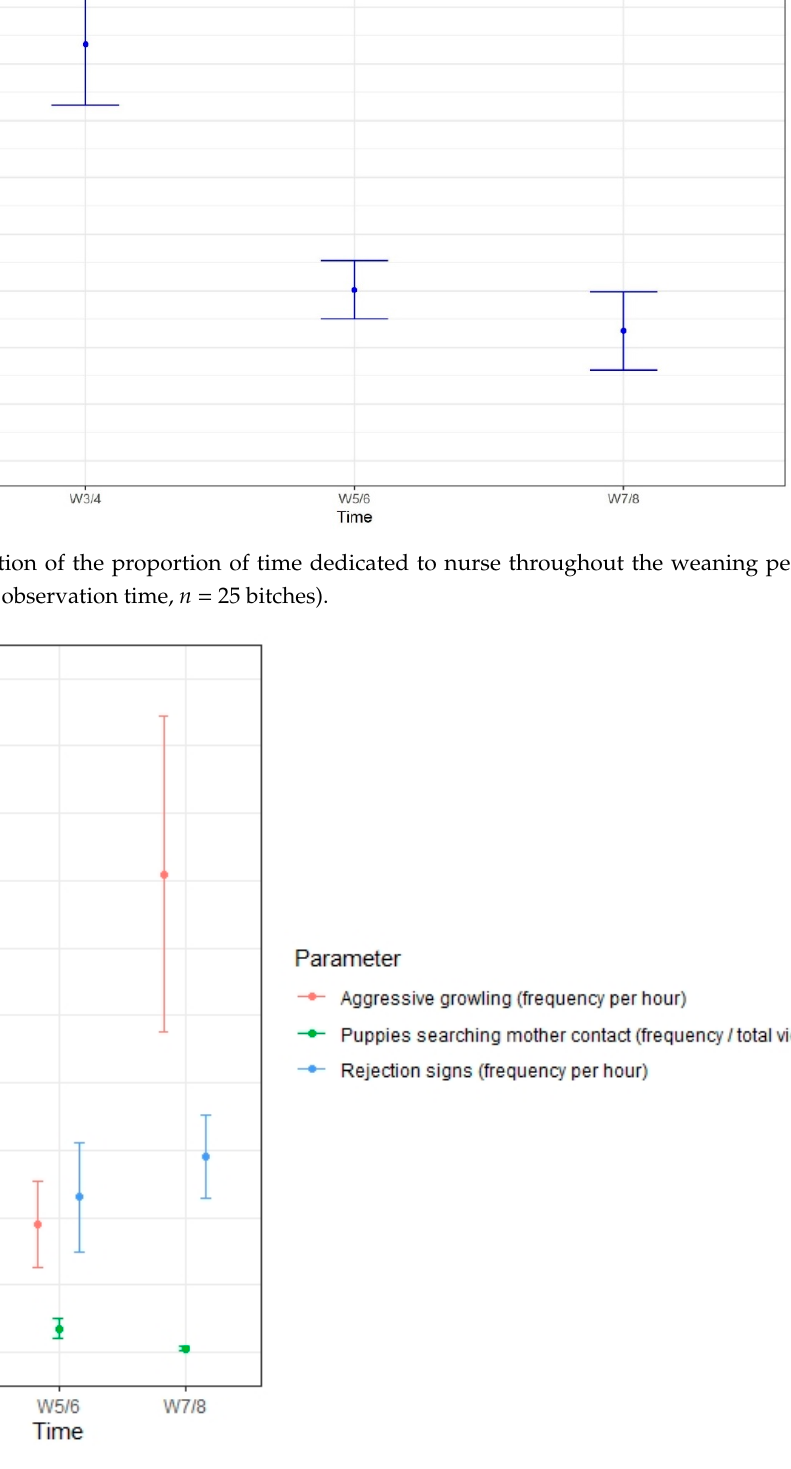
Figure 2. Comparison of the evolutions throughout the weaning period of the frequency of puppies searching contact from the dam as opposed to the dams’ reactions by aggressive growling or rejection (n = 25 bitches).